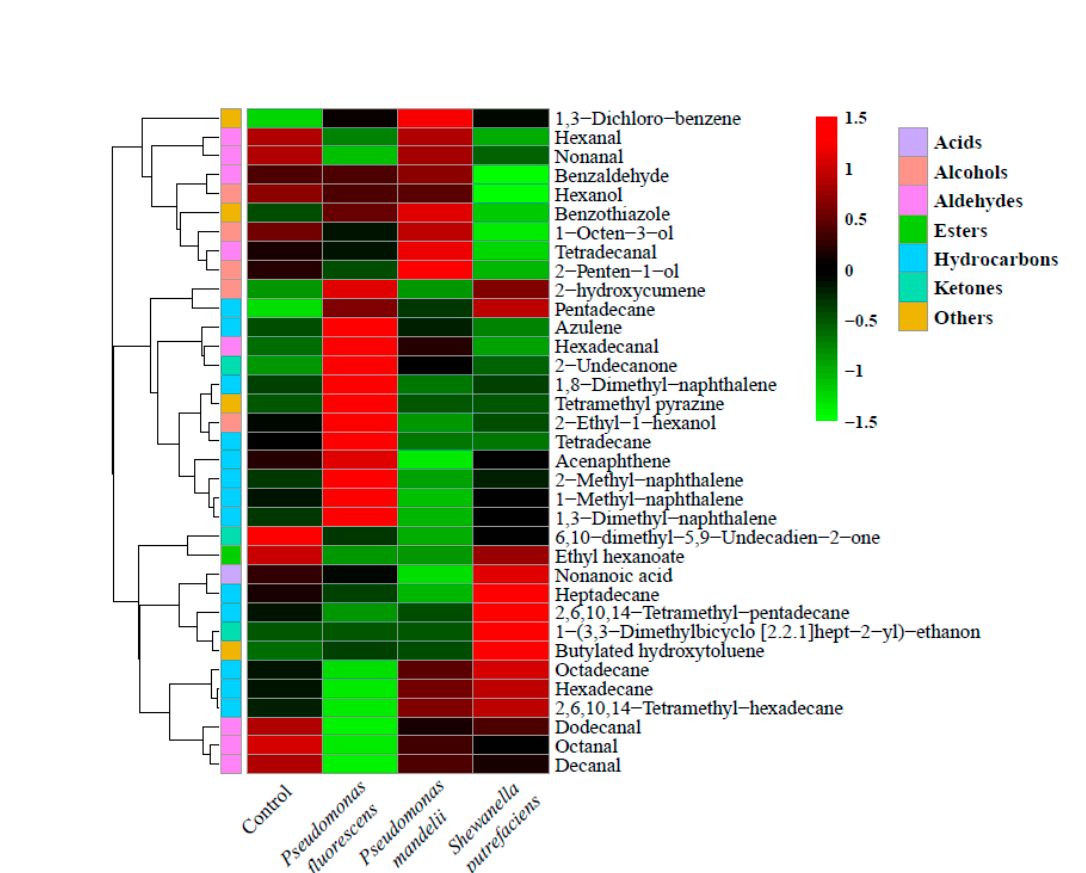
Figure 4. Total ion current diagram of volatile compounds and heat-map in sturgeon fillets inoculated with different bacteria stored aerobically on ice. Control ( A ); Pseudomonas fluorescens ( B ); Pseudomonas mandelii ( C ); Shewanella putrefaciens ( D ); heatmap ( E ). The level 3 pathways annotations were described on the left and colored according to level 2 categories. Acids, alcohols, aldehydes, esters, hydrocarbons, ketones, and other families were colored in violet, red, pink, green, blue, pistachio green, and yellow respectively. The hierarchical clustering tree was on left based on